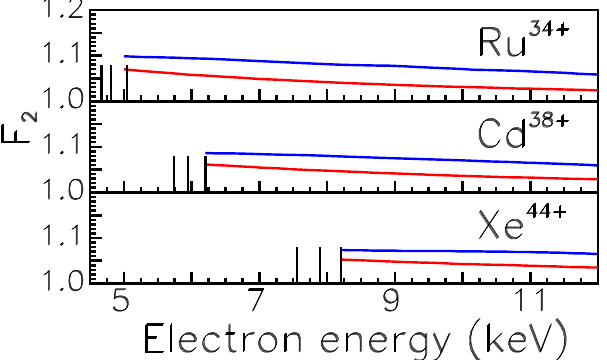
Figure 7. The enhancement factor F Red, present calculations; blue, the exact non-relativistic calculations [31]. Vertical lines denote ionization energies of the 2 p DF